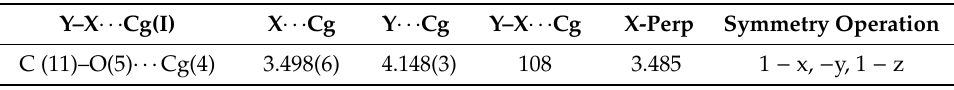
Table 4. Parameters (Å, ◦ ) for Y–X ··· π interactions in compound ( 1